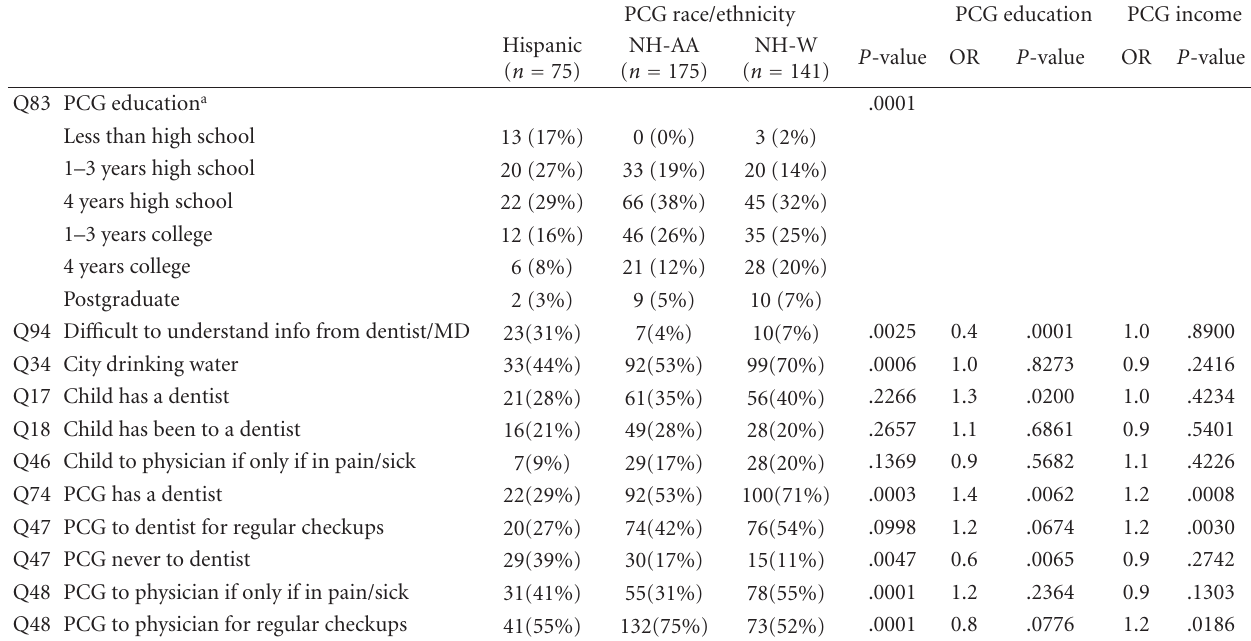
Table 1: Relationships of race/ethnicity, education, and income with questionnaire responses for demographics and access to care. Association of PCG education with race/ethnicity was tested using ANOVA. Remaining analyses were performed for each questionnaire item using multivariable logistic regression models with race/ethnicity, income, and education as predictors. Race/ethnicity P -values are for the overall test of any di ff erence among the three groups. Questionnaire item numbers are listed in the left-most column (see the appendix for questionnaire). N (%) for race/ethnicity, odds ratio (OR) for Education and Income. NH-AA = Non-Hispanic African-American, NH-W = Non-Hispanic